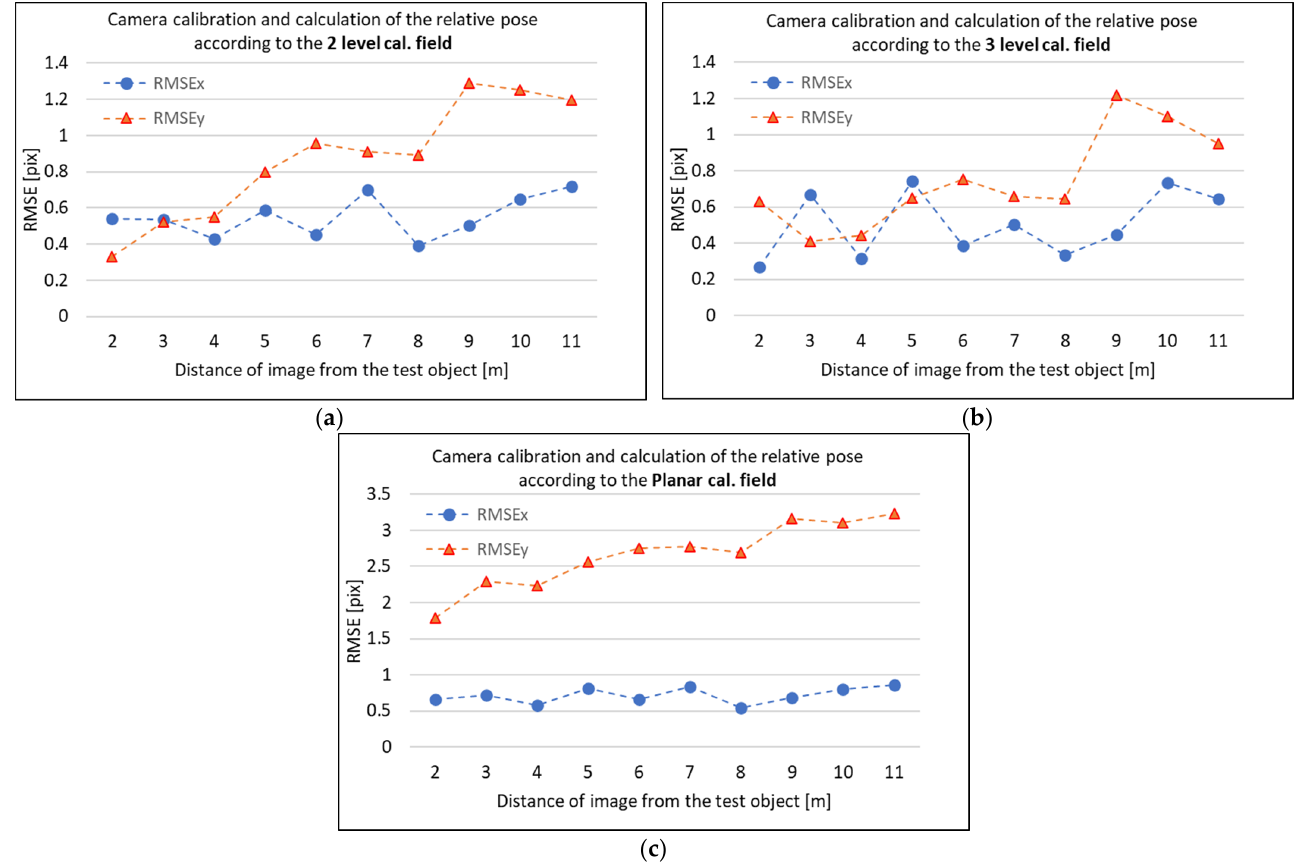
Figure 12. RMSEx and RMSEy of residuals (on TIR images) of spatial transformation using different result parameters ΔX, ΔY, ΔZ, Δω, Δφ, Δκ: ( a ) parameters calculated on the 2-level calibration field; ( b ) parameters calculated on the 3-level calibration field; ( c ) parameters calculated on the plane calibration field.